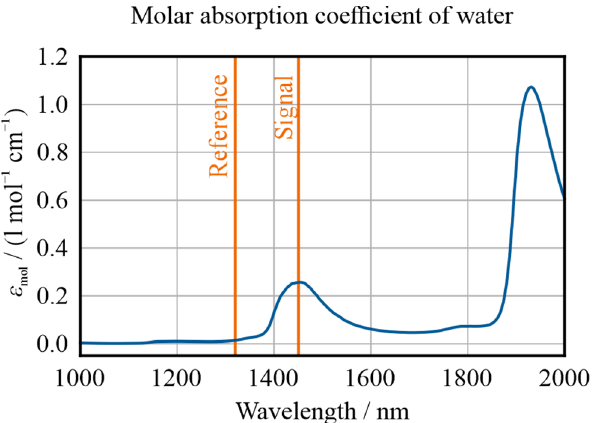
Figure 1. Molar absorption coefficient of water according to literature [14]. The two red lines indicate the wavelengths the LiDAR system employs at 1320 nm and 1450 nm.